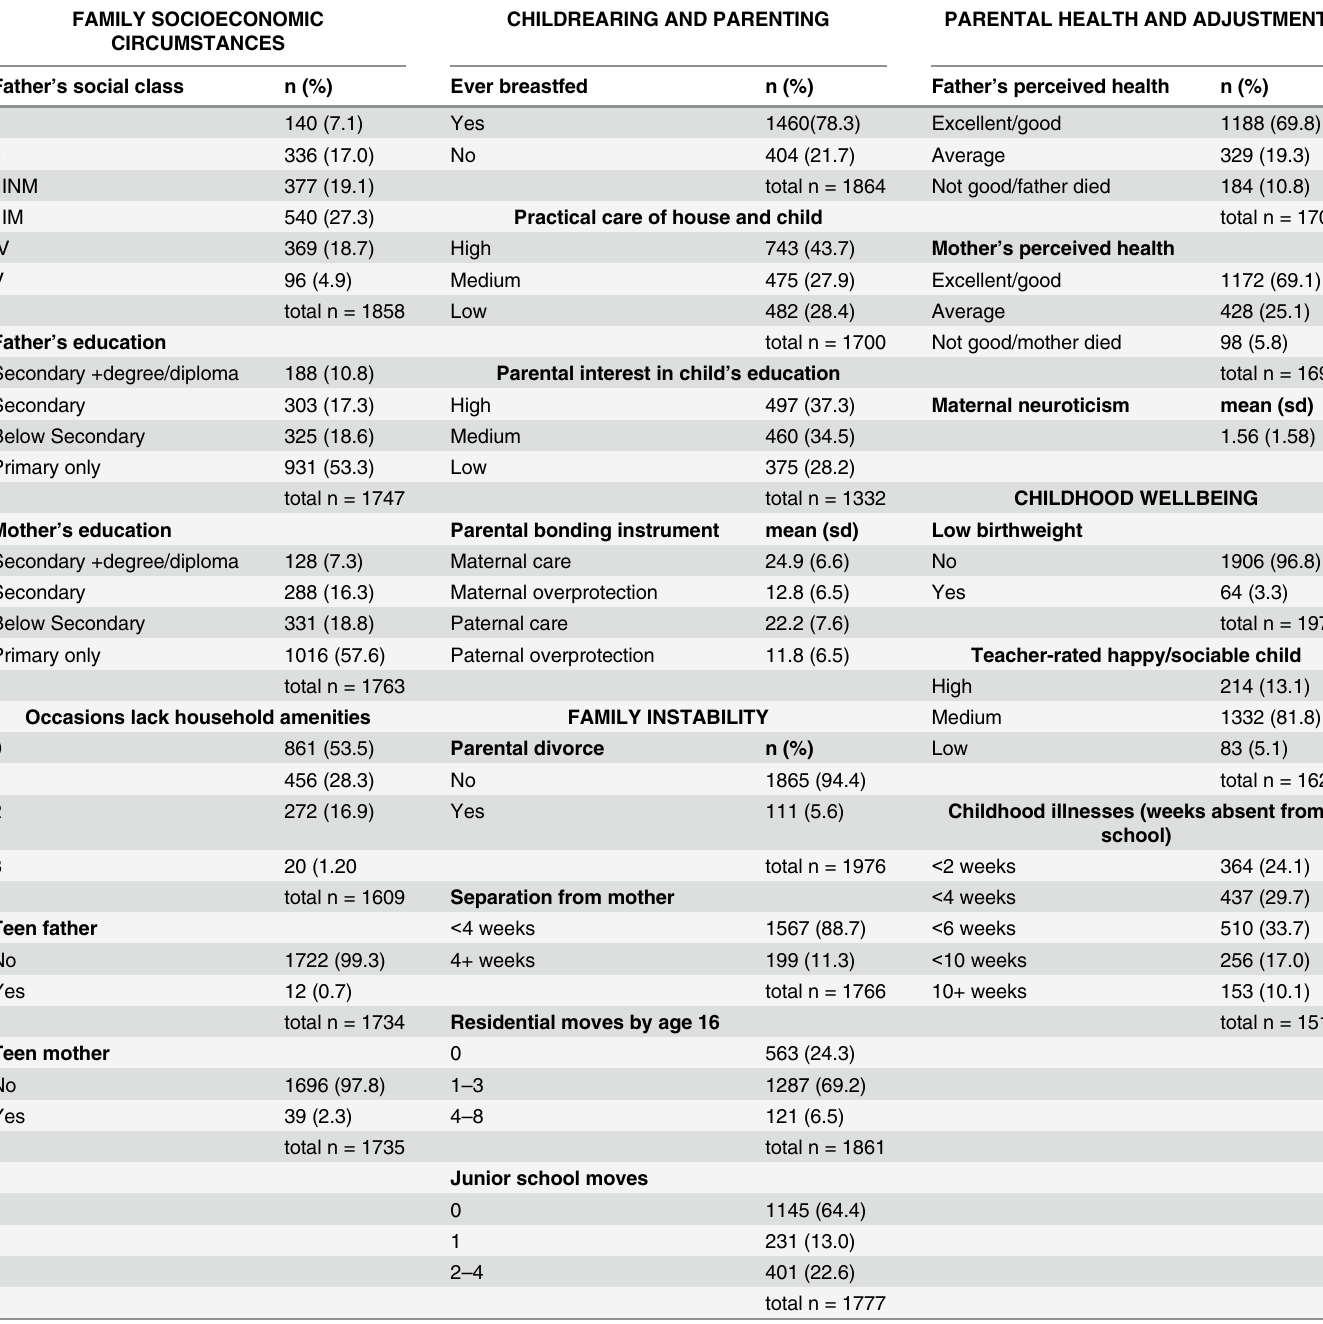
Table 1. Childhood circumstances among members of the MRC National Survey of Health and Development who provided mental wellbeing data in 2006 – 11. FAMILY SOCIOECONOMIC CHILDREARING AND PARENTING PARENTAL HEALTH AND CIRCUMSTANCES